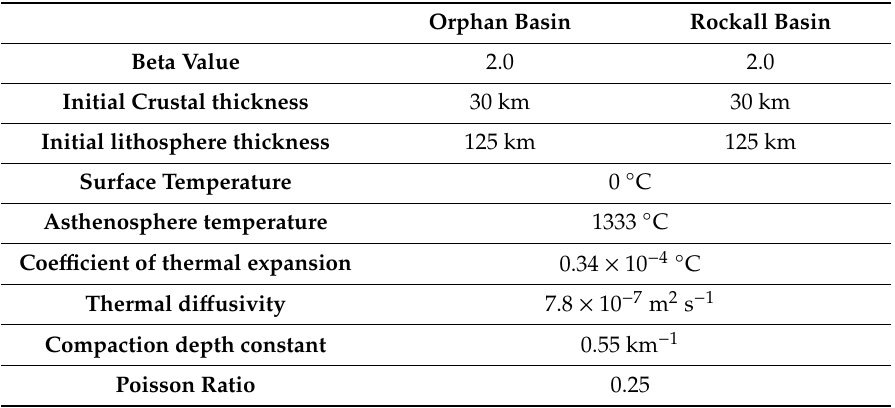
Table 4. Additional parameters used in both the decompaction and thermal subsidence calculations within MOVE TM . Values are identical to those used by